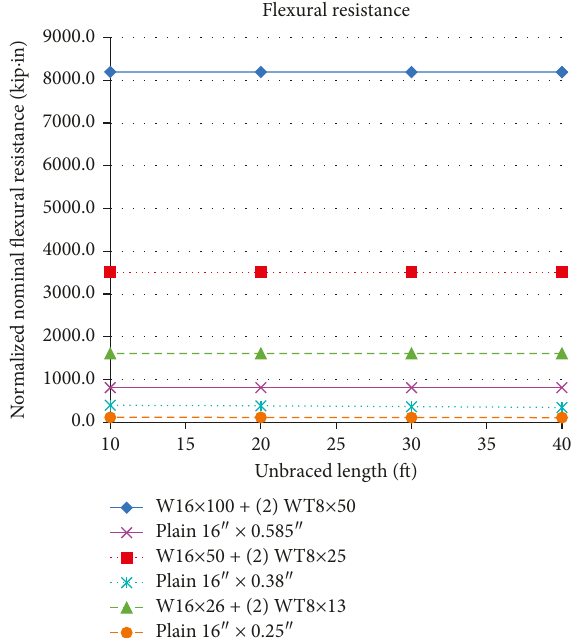
Figure 7: Flexural resistance for comparative plain and flanged cruciform members (1ft